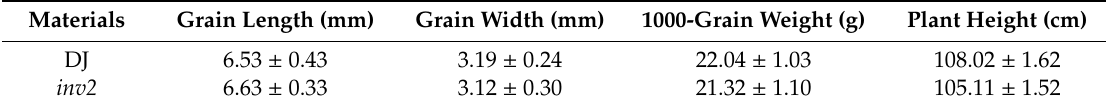
Figure 7. OsINV3 / SG2 expression pattern and protein subcellular localization. ( A ) Quantitative real-time PCR analysis of OsINV3 expression in various tissues of wild-type plants. R, LB1, root and leaf blade at seedling stage; C, LB2, LS, culm, leaf blade, leaf sheath at booting stage, respectively; YP1-YP15, young panicles with different length (cm). E3-E9, endosperm, the number indicates the days after fertilization. Data are given as mean ±SD. ( n = 3). OsActin was used as the control. ( B ) Subcellular localization of OsINV3 observed in rice protoplasts. Scale bar, 10 µ m. Table 2. Agronomic traits of Dongjing (DJ) and